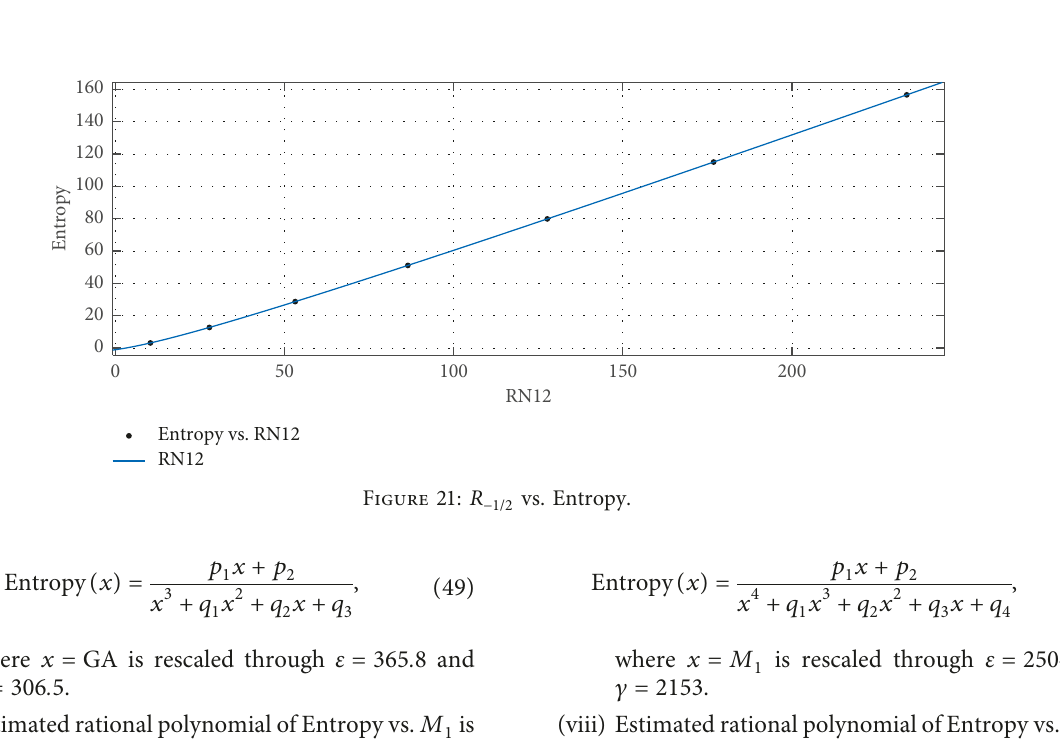
Figure 21: R − 1/2 vs.